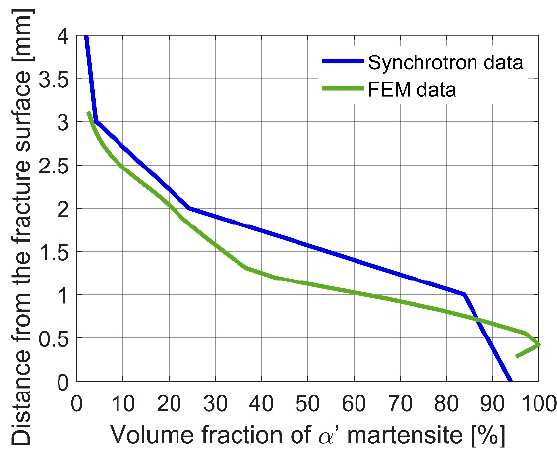
Figure 19. Synchrotron measurements compared with FEM results.